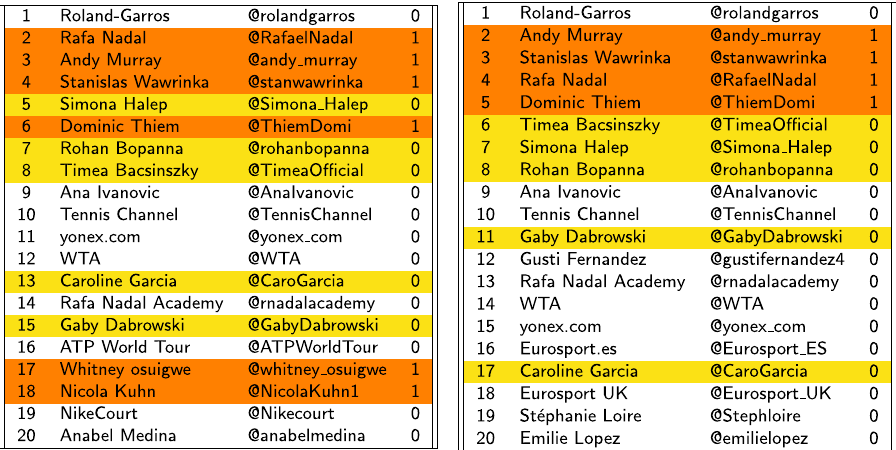
Relevant daily players are highlighted orange. Accounts of players who did not play on this day are highlighted